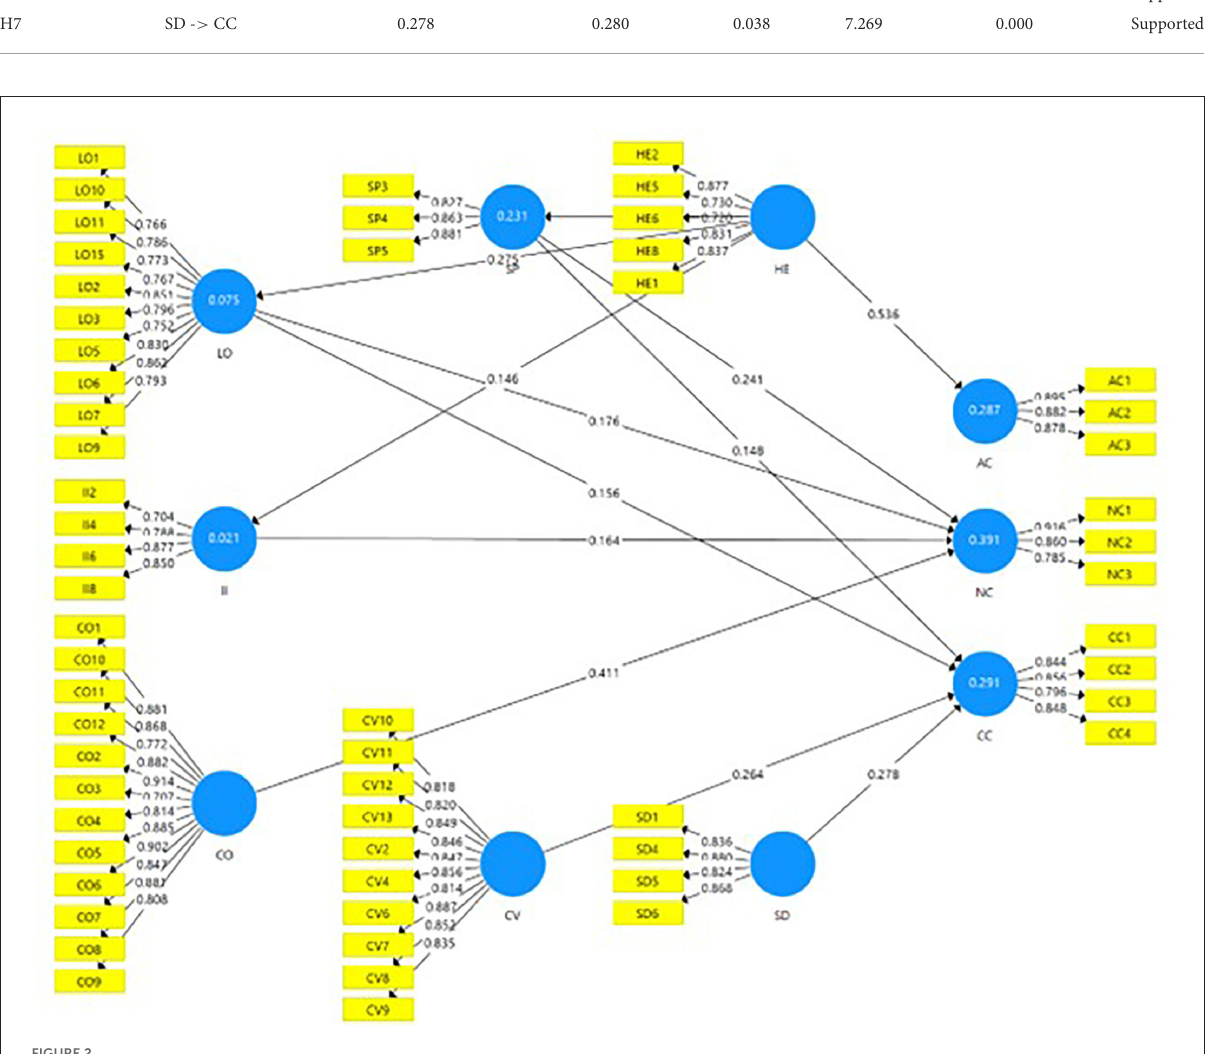
FIGURE2 Structural equation modeling (SEM)